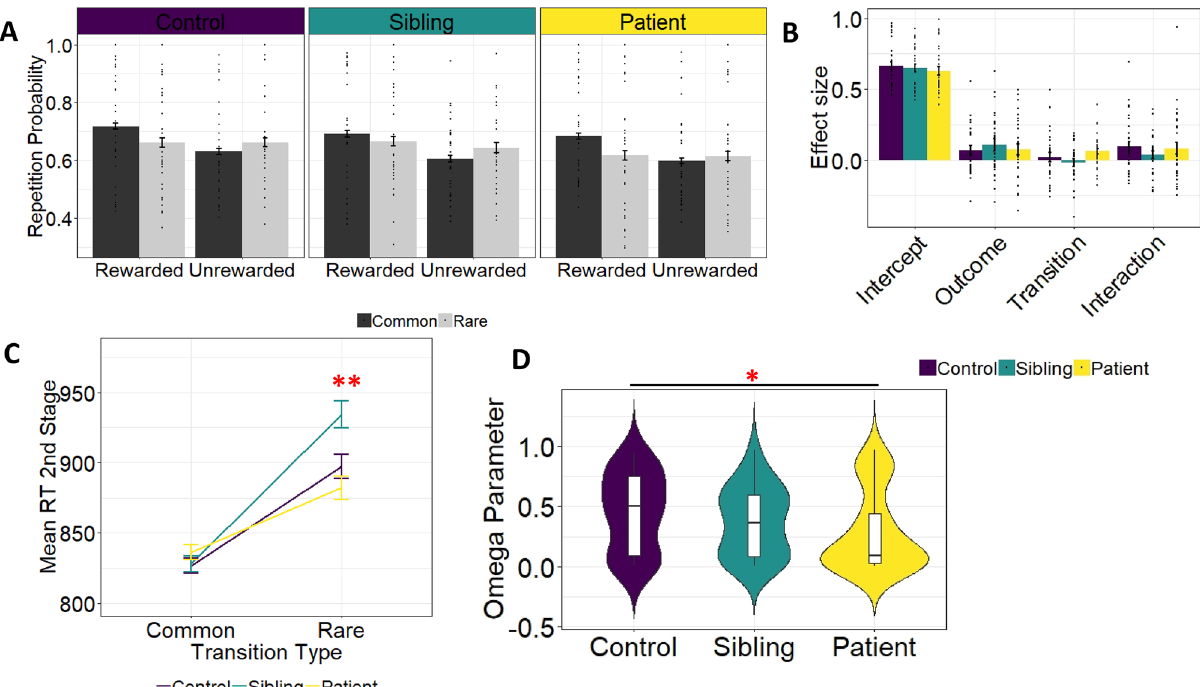
Figure 1. ( A ) Repetition probabilities and ( B ) results of the regression analysis where we regressed stay/switch behavior on outcome (Reward, No Reward), transition (Common, Rare) and group (Control, Sibling, OCD). We found no evidence that groups showed significant different choice behaviors in model-free (Outcome effect in Figure B ) or model-based (Interaction effect in Figure B ) control. Moreover, general stay/switch behavior was not significant different between groups (Intercept effect in Figure B ) and choice behavior was not different across groups after rare or common trials (Transition effect in Figure B ). ( C ) Mean 2nd stage reaction time as a function of transition type and group (MB RTs). OCDs discriminated less between common and rare trials in their RTs (common: m = 836 ms, sd = 351 ms, rare: m = 882 ms, sd = 361 ms) compared to HCs (common: m = 826 ms, sd = 352 ms, rare: m = 897 ms, sd = 365 ms, group difference, p < 0.01) and SIBs (common: m = 828 ms, sd = 342 ms, rare: m = 934 ms, sd = 385 ms, group difference, p < 0.001) (indicated with **). The difference between SIBs and HCs showed trendwise significance (p = 0.0503). ( D ) Comparison of the computational parameter ω, indicating the balance between model-free and model-based control, between groups. Jonckheere-Terpstra testing showed ordered difference for the ω parameter (indicated with ence between SIBs and HCs showed trendwise significance ( b = − 17.1, SE = 8.7, CI 95% [− 34.12 0.02], P = 0.0503) (Fig. 1C).